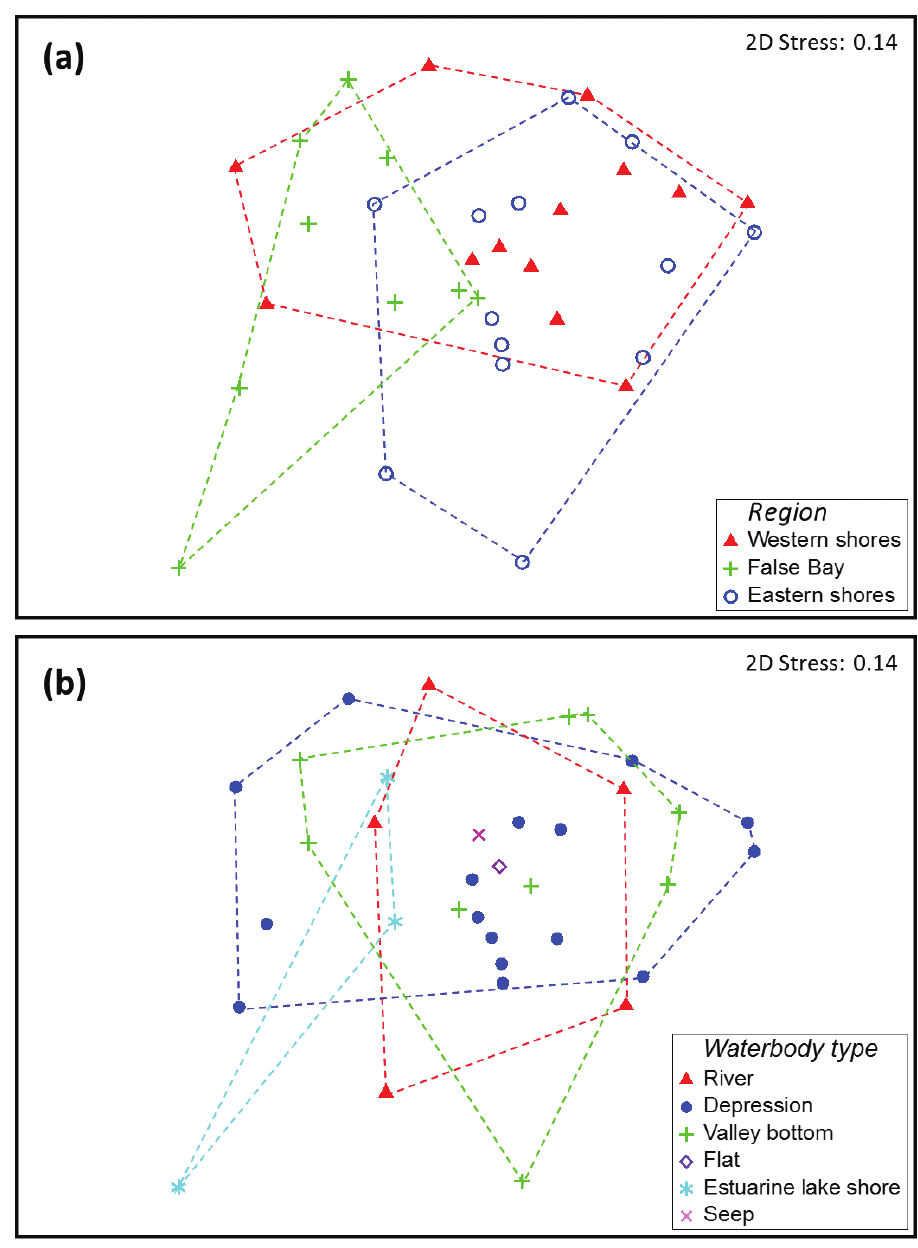
Figure 2. Multidimensional scaling (MDS) plot depicting the similarity of sites sampled in this study in terms of beetle assemblage composition. Symbols on the plot have been coded in terms of ( a ) region and ( b ) waterbody type. Convex hulls (dashed lines) have been overlaid on each plot to clarify groupings according to region/waterbody